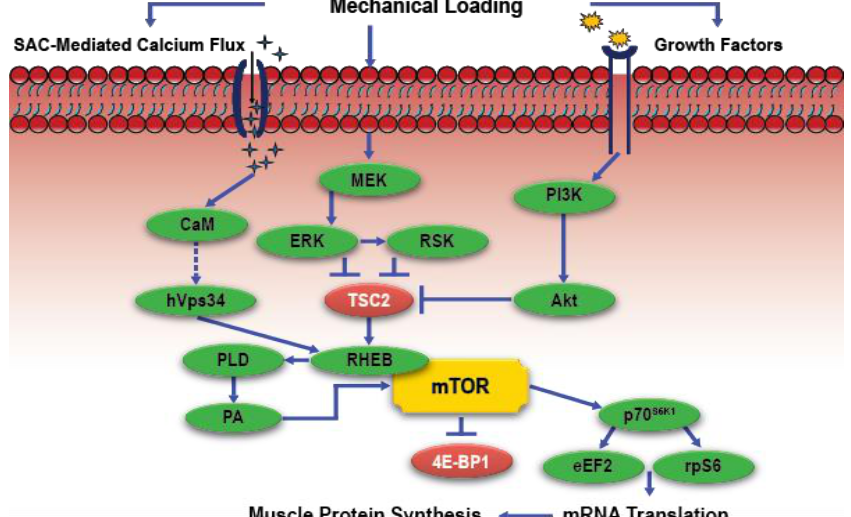
Figure 1. Simplified schematic of mechanotransduction-mediated anabolic